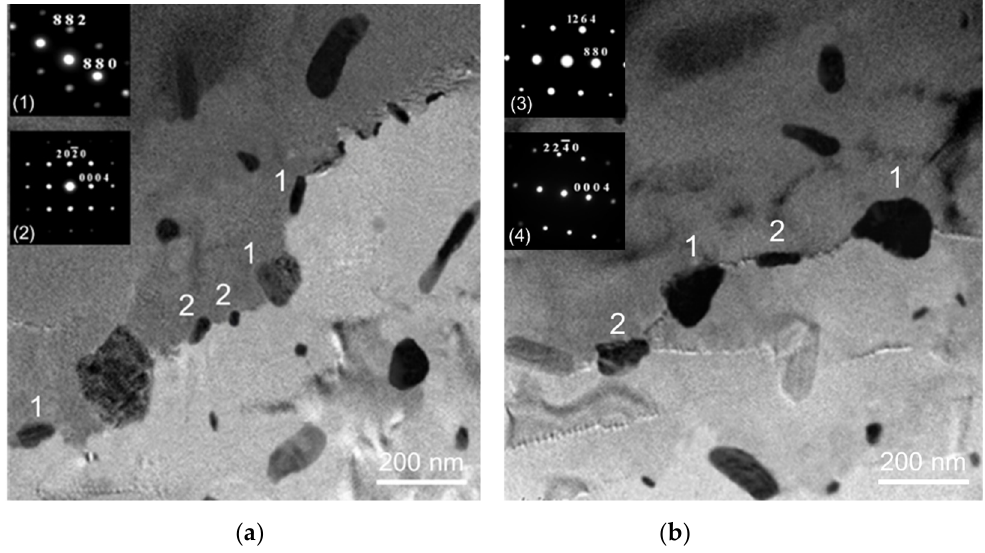
Figure 9. TEM photomicrographs of alloy D ( a ) homogenization and furnace cooling ( b ) homogenization, furnace cooling and sensitization (1: Mg 2 Al 3 , 2: MgZn 2 ).